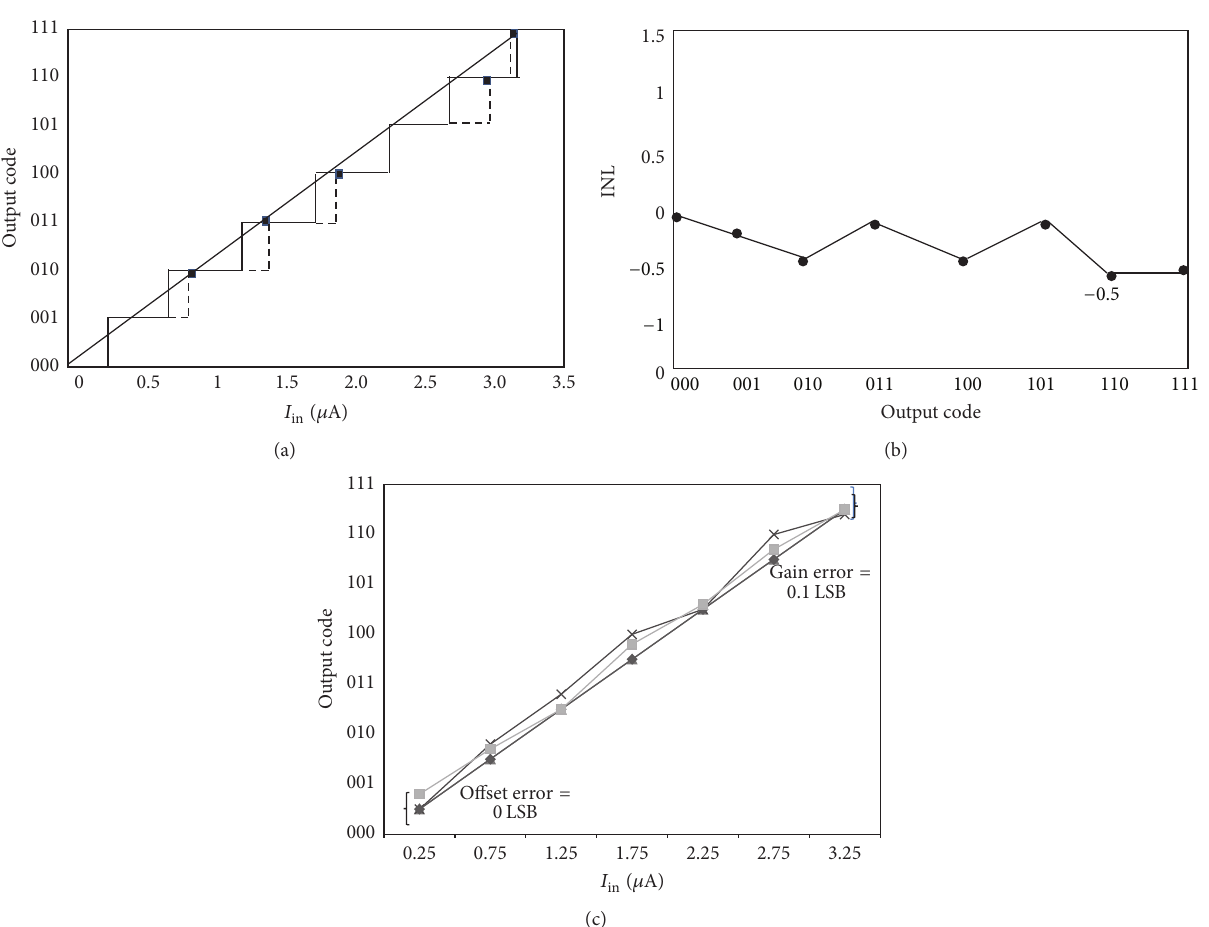
by the difference in slope of actual best fit line and the ideal best fit line at the last transition, which is found to be 0.1 LSB for this